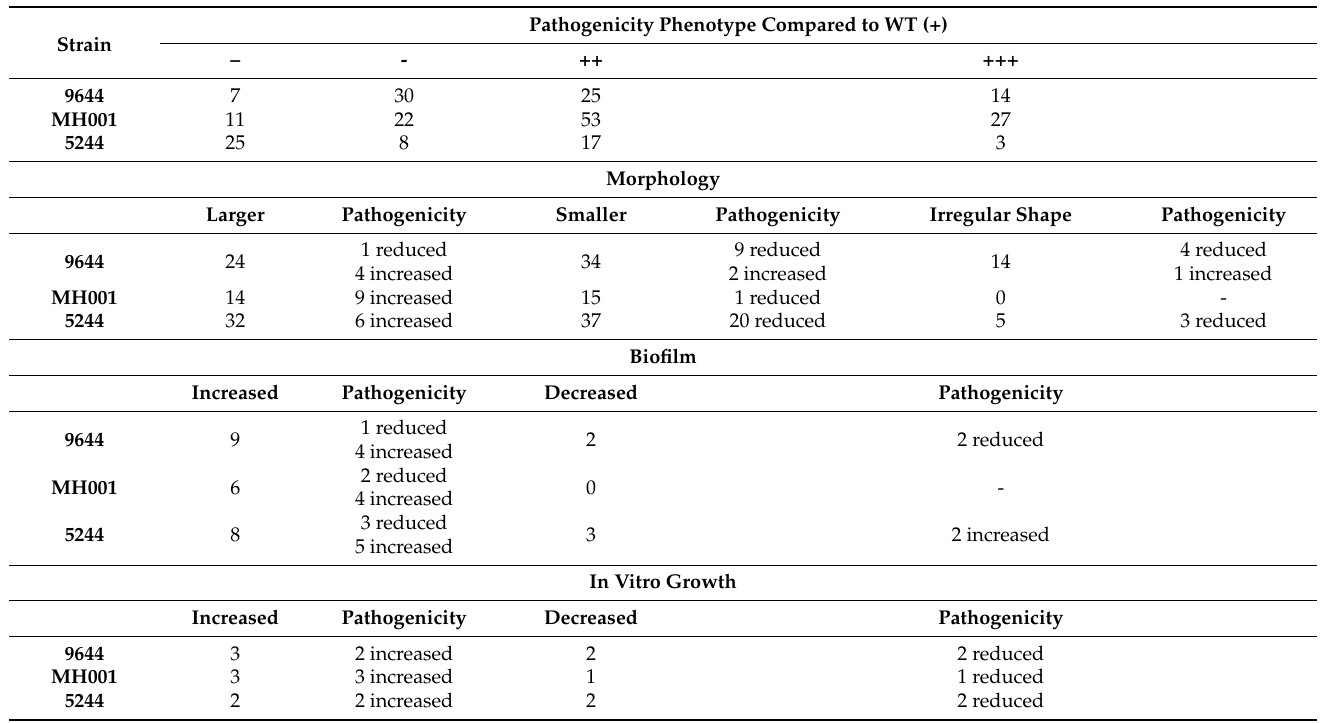
Table 2. Numbers of transposon disruption mutants selected with modified phenotypes after screening 940 Tn insertions in each strain.